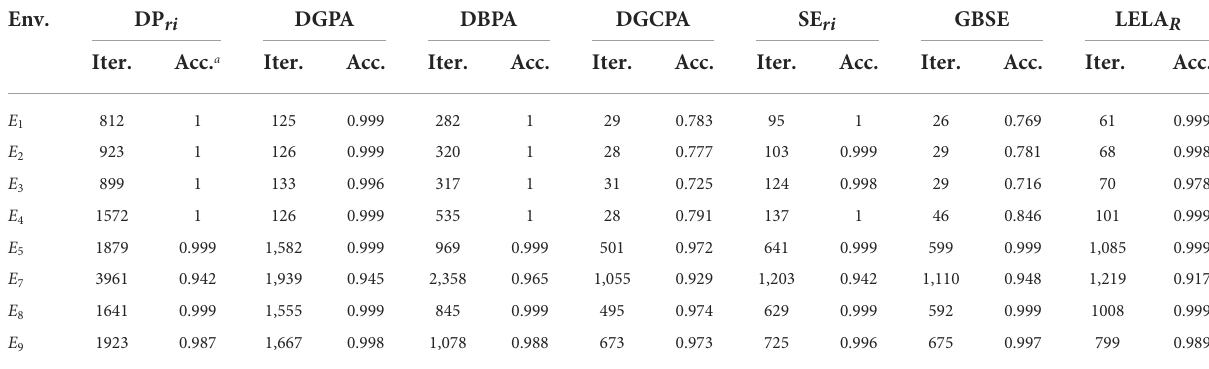
TABLE 6 Comparison of convergence rate and accuracy of the parameter-based algorithms in all environments other than E 6 , when using the “best” learning parameters in E 6 . Env. DP ri DGPA DBPA DGCPA SE ri GBSE LELA R Iter. Acc. a Iter. Acc. Iter. Acc.